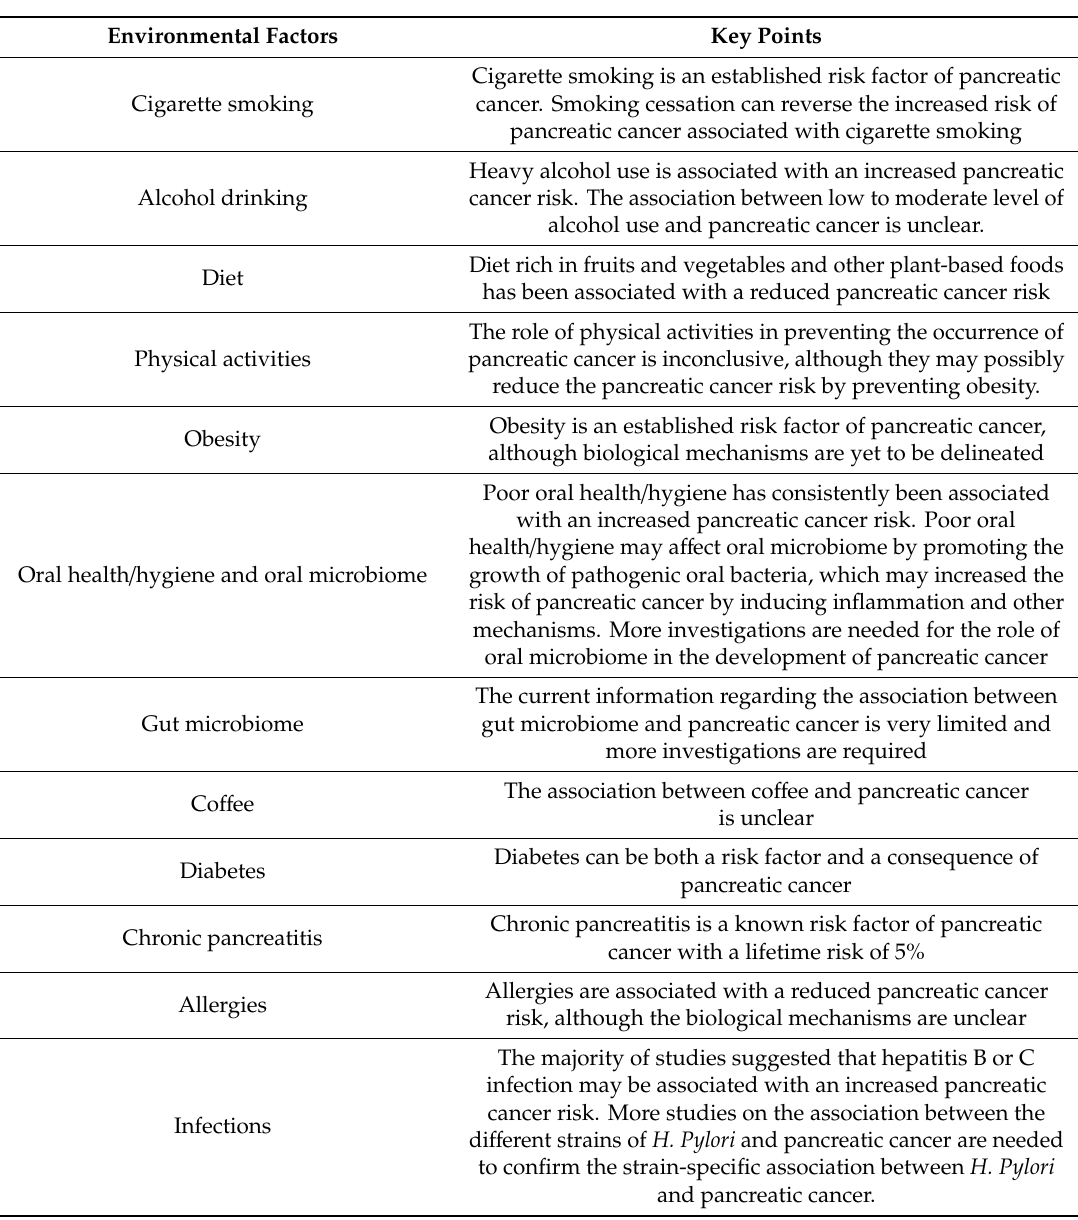
Table 2. Summary of key points for each of the environmental factors discussed in this